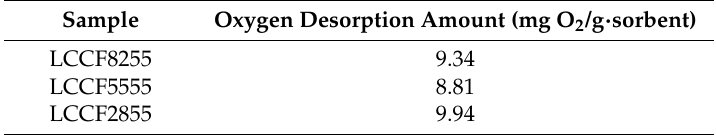
Table 2. Oxygen desorption amount of La 1 − x Ca x Co 0.5 Fe 0.5 O 3 − δ (x = 0.2, 0.5,